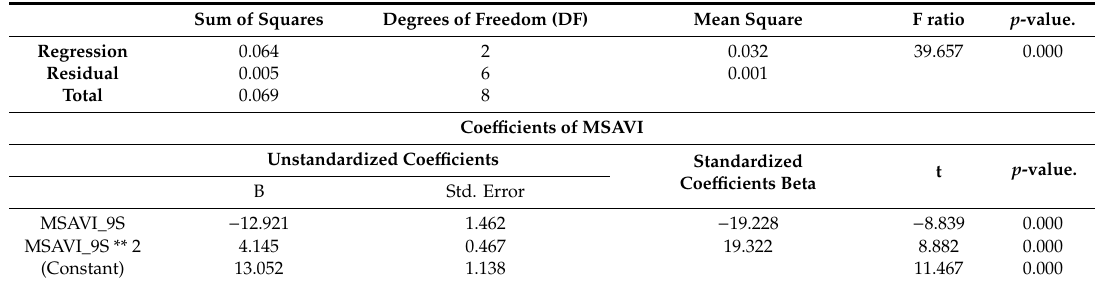
Table 9. Analysis of variance of the modified soil adjusted vegetation index. Sum of Squares Degrees of Freedom (DF) Mean Square F ratio p -value.